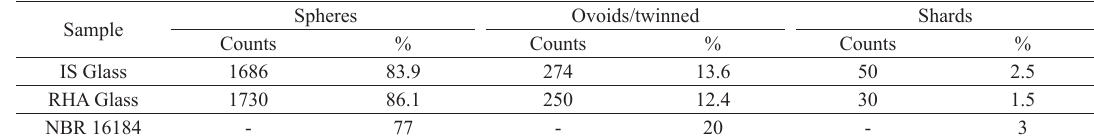
Table 2. Percentage of different elements generated after the spheroidization process and Brazilian standard as reference. Sample